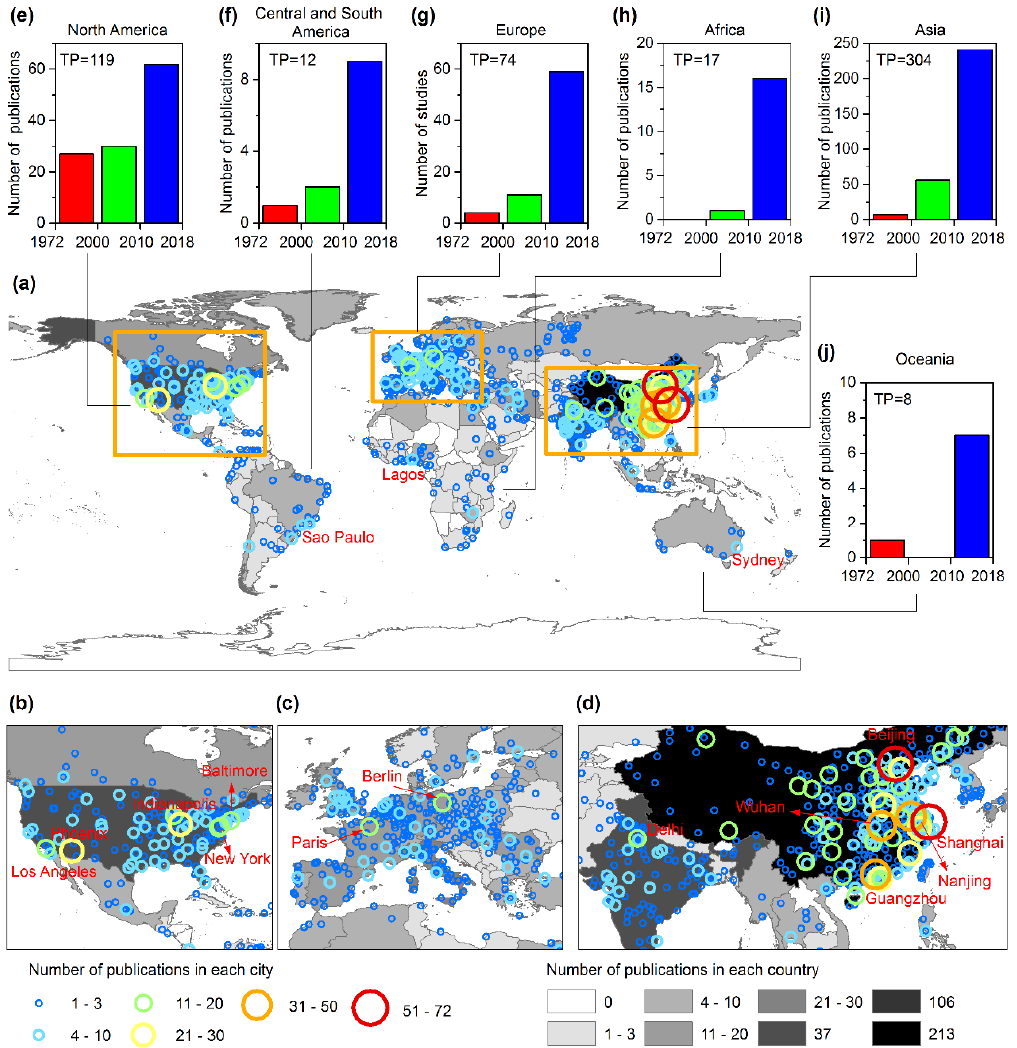
Figure 2. Geographic distribution of the selected SUHI literature based on the study location. ( a ) The number of studies per city (empty cycle) and country (background color), ( b – d ) the enlarged view of the SUHI publications in North America, Europe, and Asia, and ( e – j ) the number of publications in each continent. One study may cover a series of cities distributed in different countries and/or continents. Two global-scale studies [2,50] were not included in this summary since they did not specify the studied cities. Three regional-scale studies [3,5,51] were not counted in the number of publications in each city (panels a to d) because they focused on the SUHIs of all cities in spite of city size. TP represents the total publications in each continent.